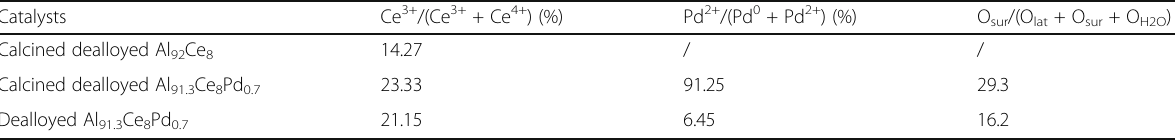
Table 2 Ratios of Ce, Pd, and O in different states for different catalysts, as obtained from the XPS results